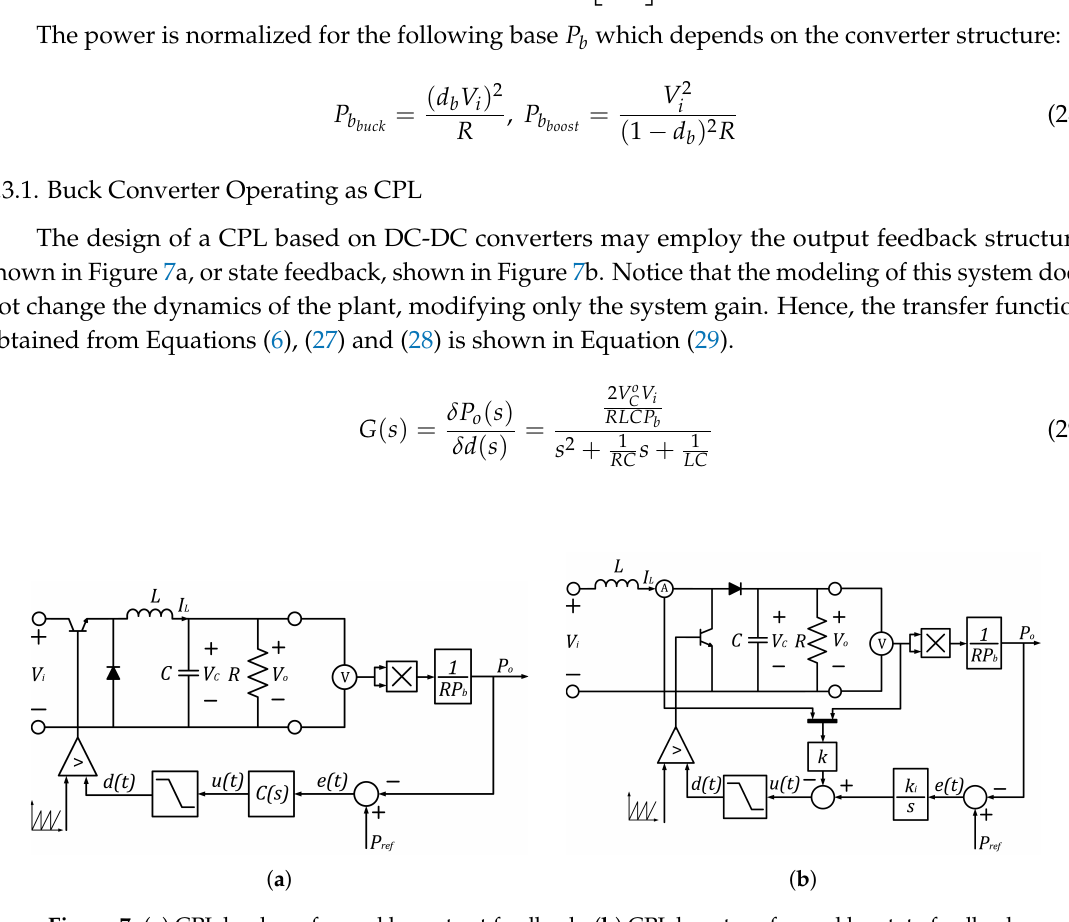
Figure 7. ( a ) CPL buck performed by output feedback. ( b ) CPL boost performed by state